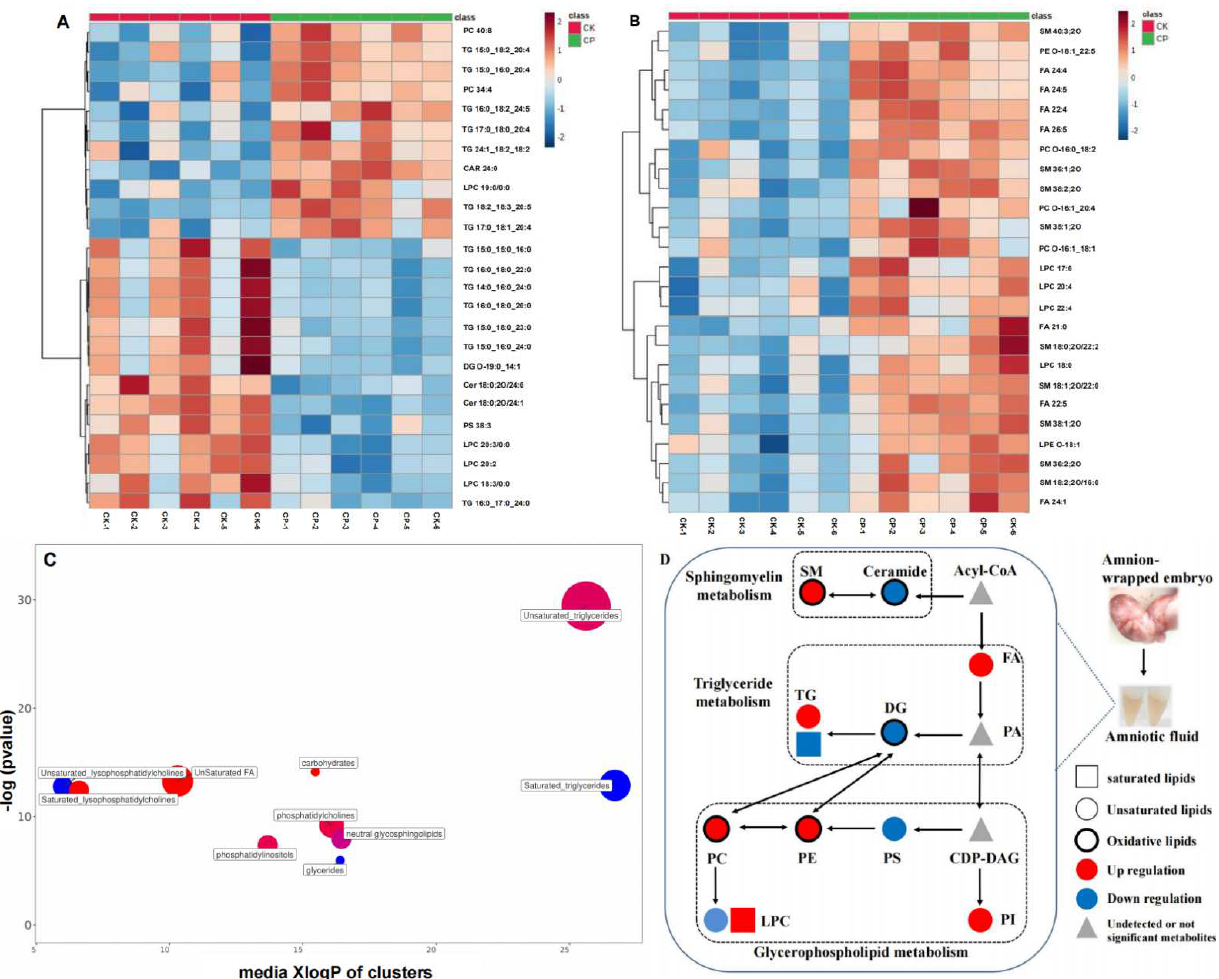
Figure 6. Differentially expressed lipids between the CP and CK groups. Heatmaps of the top 25 differential amniotic fluid lipids in the ( A ) positive and ( B ) negative ion modes ( n = 6). Each square corresponds to the peak intensity of lipids. Red or blue squares represent increases or decreases in concentration. Dark red or blue squares stand for higher increase or decrease degrees of concentration. ( C ) ChemRICH enrichment analysis of differential lipids ( n = 6). Each node represents a cluster of differential lipids. Node sizes represent the total number of lipids in each cluster. Red or blue nodes stand for the clusters with most lipids upregulated or downregulated. Deep pink nodes include both upregulated and downregulated lipids. ( D ) Metabolic pathway network of differential lipids. The rectangle represents saturated lipids, the circle represents unsaturated lipids, the thick black border represents oxidized lipids, the blue color represents downregulation, the red color represents upregulation, and the gray triangle represents undetected or not significant lipids.